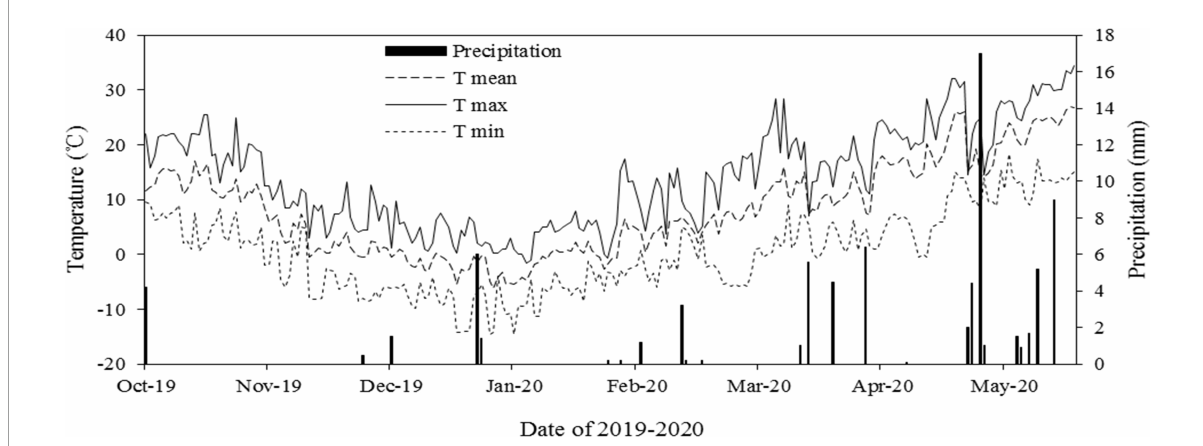
FIGURE2 Meteorological conditions during the field experiment from October 16, 2019 to June 10,